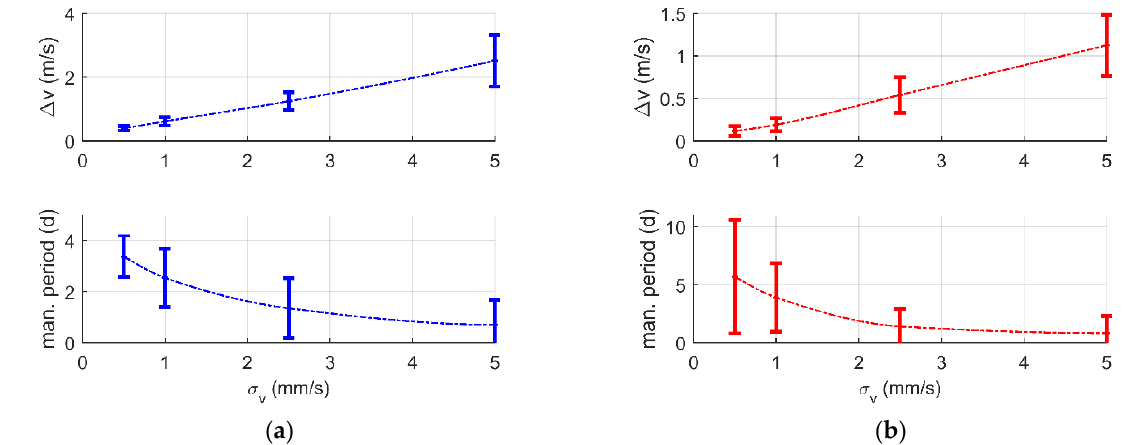
Figure 8. Sensitivity analyses for maintenance of low-inclined ( a ) and Sun-synchronous ( b ) formations in the presence of navigation errors ( σ p = 1 cm). Total ∆ v and maneuvering period over the first 30 days of mission— h = 550 Table 4. Statistics related to the sensitivity analyses for maintenance of low ‐ inclined formations in the presence navigation errors ( (cid:2026) (cid:3043) (cid:3404) 1 cm).